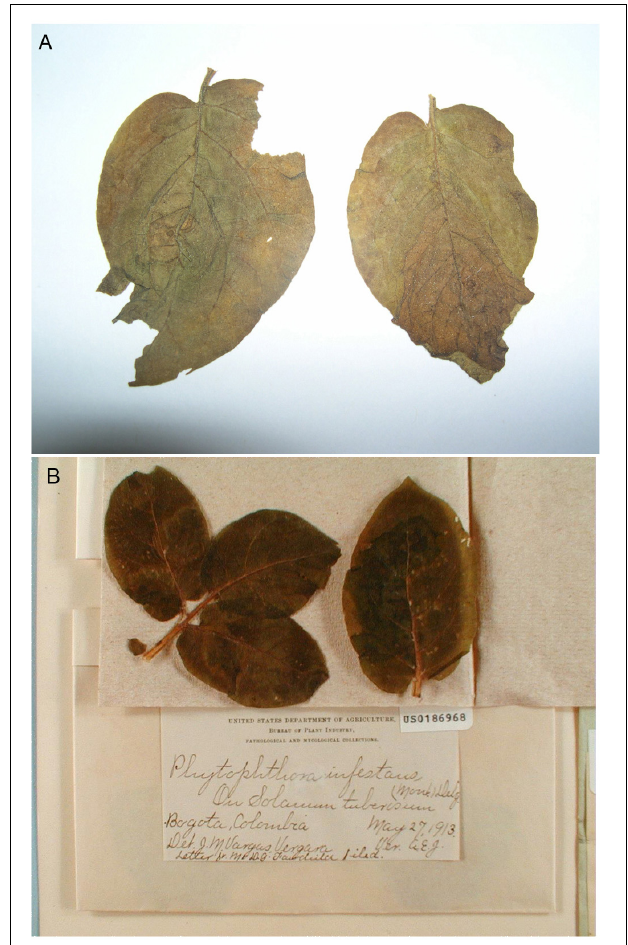
FIGURE 1 | Phytophthora infestans -infected potato collected in (A) Sweden in 1882 by Jacob Eriksson from the herbarium in Uppsala, Sweden. (B) Sample collected in Bogata, Colombia by J. M. Vargas Vergana in 1913 (BPI186968). Disease in both samples was caused by the FAM-1 lineage of P. infestans .